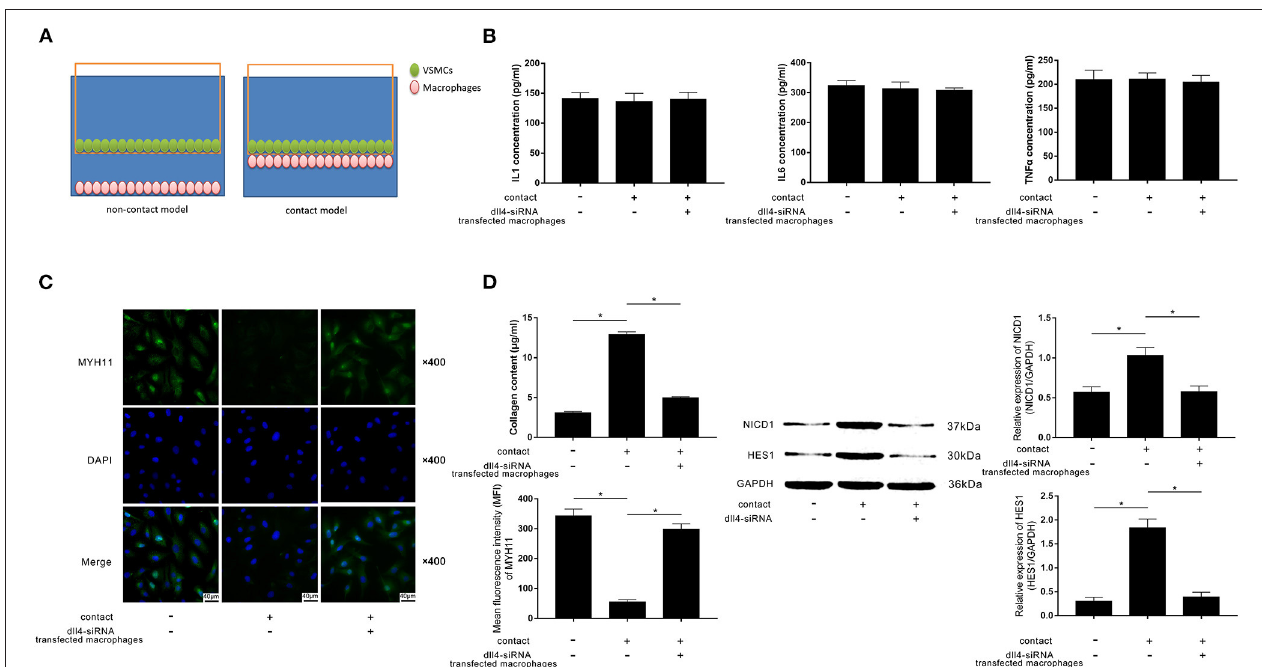
FIGURE 4 | (A) Schematic diagram of the non-contact and contact co-culturing models of macrophages and VSMCs is demonstrated. VSMCs in the contact co-culturing model were co-cultured with FXa- exposed macrophage transfected with or without Dll4 -siRNA. (B) Columns indicate the detected concentrations of inflammatory cytokines including IL1, IL6, and TNF α in the non-contact and contact co-culturing model systems. (C) Immunofluorescence stains of MYH11 and DAPI and their merged images of VSMCs. Columns indicate the MFI of MYH11 and collagen content of VSMCs from the non-contact and contact co-culturing models. (D) Immunoblots of NICD1, HES1, and GAPDH. Columns indicate the relative expression levels of NICD1 and HES1 in VSMCs from the non-contact and contact co-culturing models (data were presented as mean ± SD, n = 6, Student’s t -test and ANOVA, * P < 0.05).